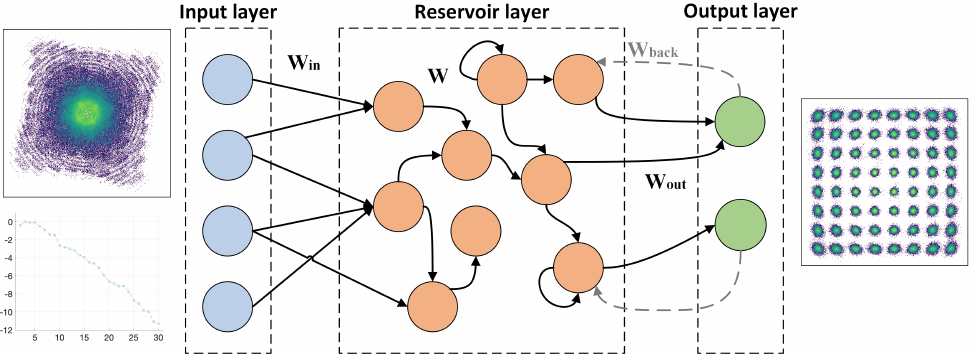
Figure 1. Diagram of PA-RC nonlinear